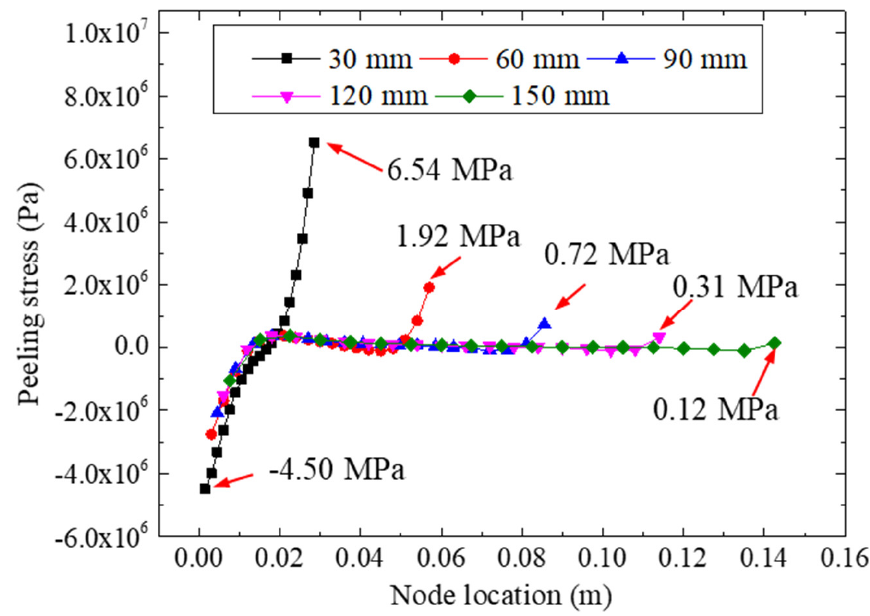
Figure 13. Peeling stresses for different bonding